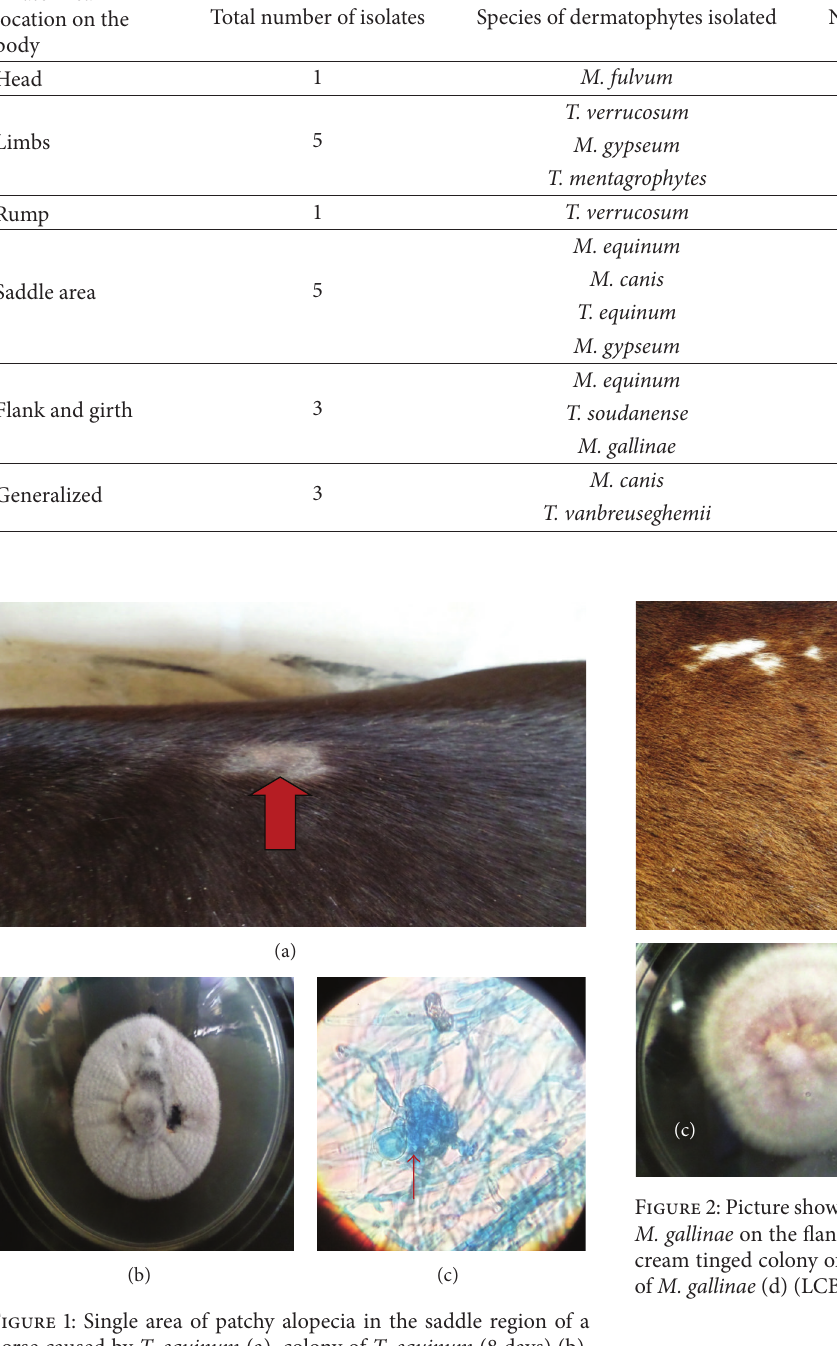
dermatophytes with a frequency of four and occurred mostly